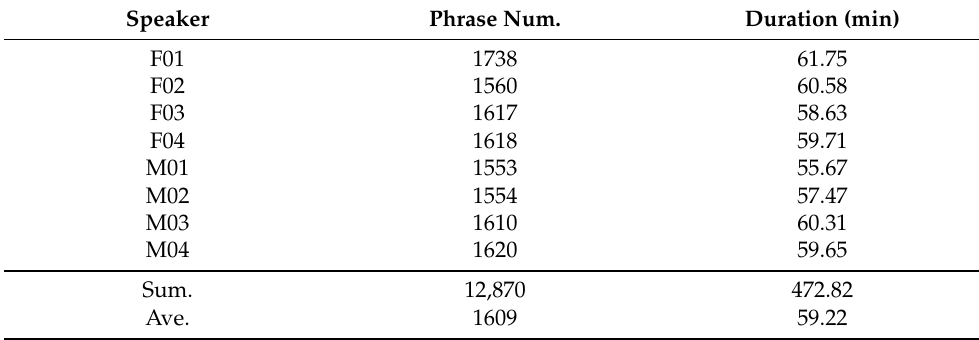
Table 1. Number of sentences and duration recorded from each